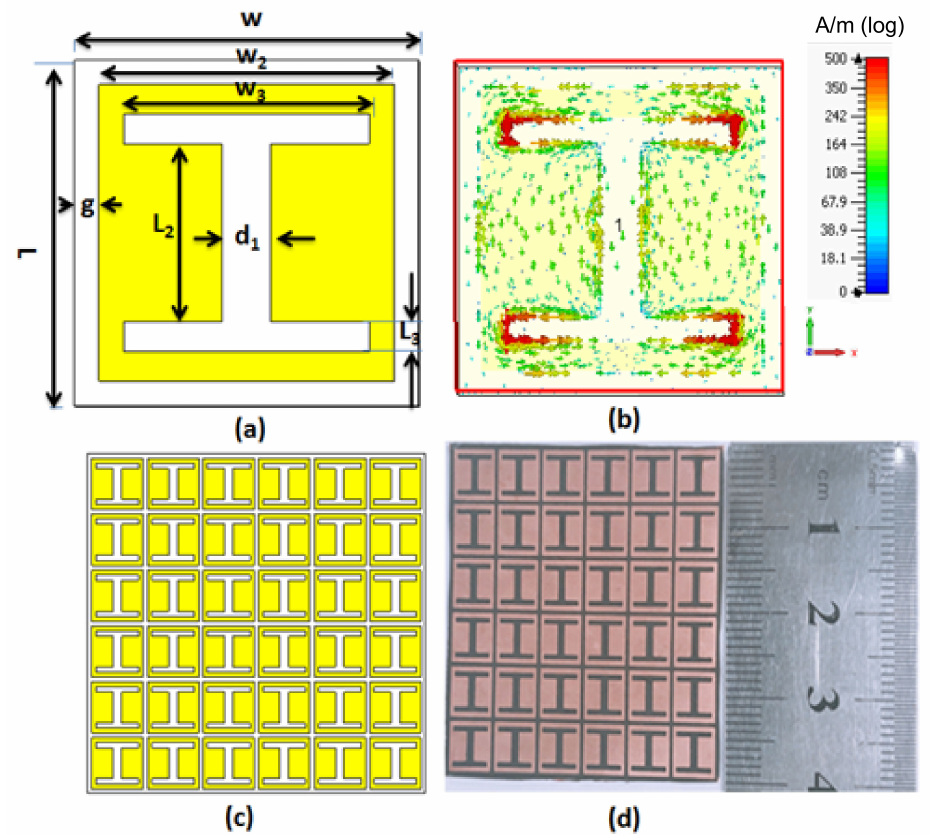
Figure 11. Proposed structure of AMC ( a ) 2D configuration of the unit cell with (w = L = 7 mm, w2 = 6 mm, w3 = 5 mm, g = 0.5 mm, L2 = 3.6 mm, d1 = 1 mm, and L3 = 0.6 mm). ( b ) Current distribution @ 28 GHz of the unit cell; ( c ) a 6 × 6 array of AMC unit cells; ( d ) fabricated photo of the proposed